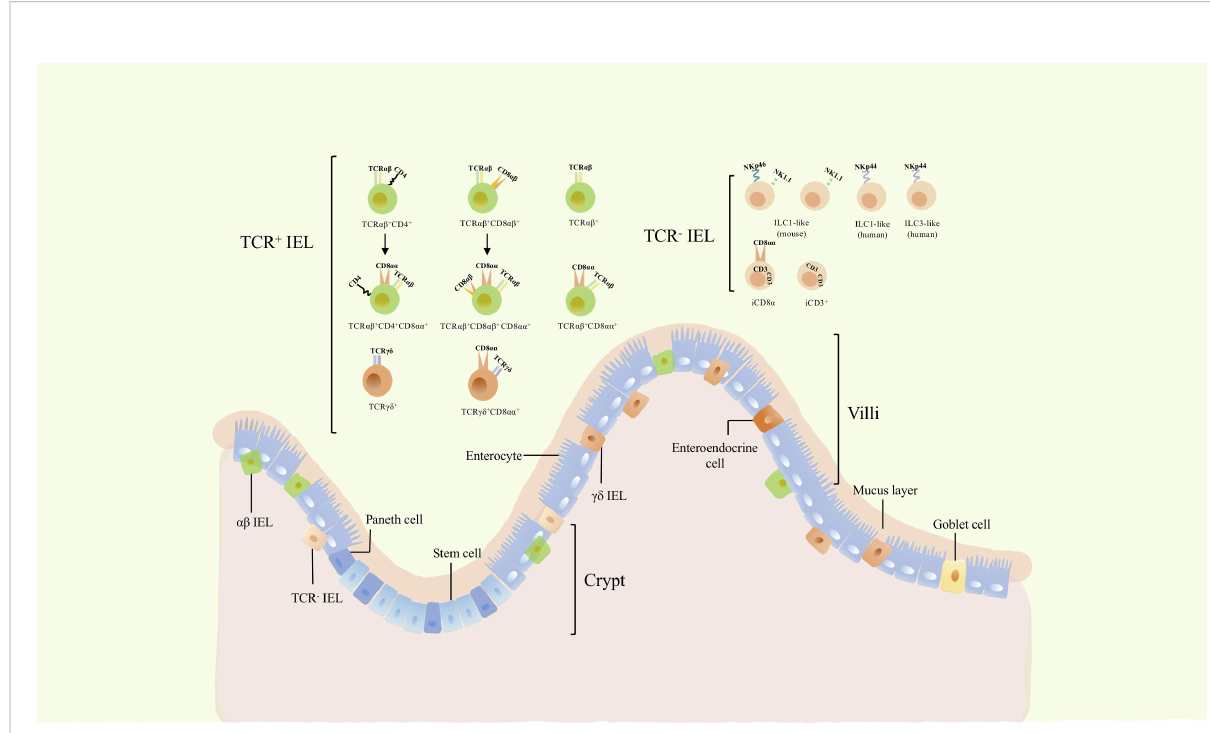
FIGURE 1 The classi fi cation and location of intraepithelial lymphocytes (IELs). Gut epithelium is composed of a single layer of enteroendocrine cells (intestinal epithelial cells). IELs are a group of heterogenous cells embedded within intestinal epithelium. Dependeing on the expression of TCR, they can be divided into TCR + and TCR - IELs. TCR + IELs include ab and gd T cells. The former includes TCR ab + CD4 + , TCR ab + CD8 ab + , as well as induced TCR ab + CD4 + CD8 aa + and TCR ab + CD8 ab + CD8 aa + cells. TCR ab + , TCR ab + CD8 aa + , gd IELs and TCR - IELs cells are natural cellular subsets. gd IELs consists of TCR gd + and TCR gd + CD8 aa + cells, while TCR - IELs comprises ILC1-like, ILC3-like, and iCD3 + cells including its special subset, iCD8 a